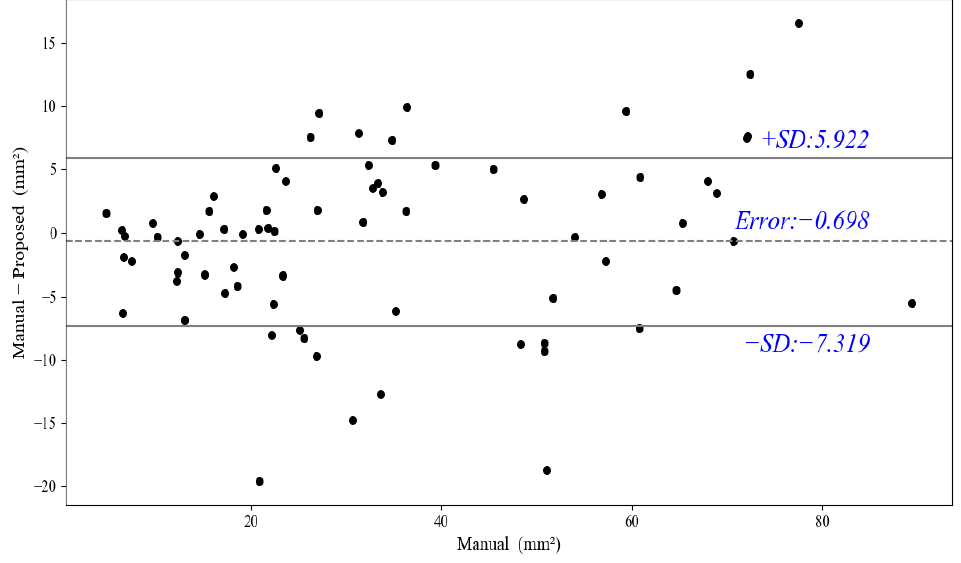
Figure 14. Plaque-area errors and standard deviations on new 75 test images.